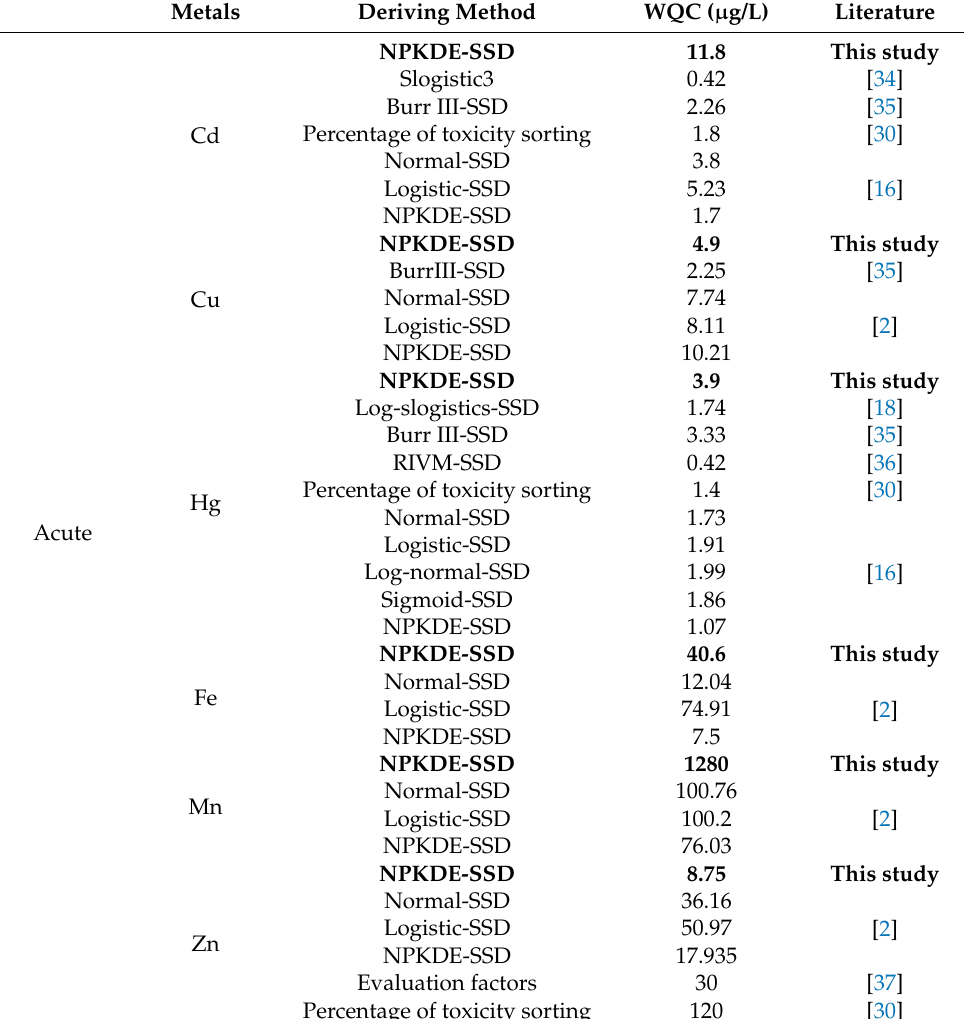
Table 2. Comparison of acute and chronic water quality criteria of transition metals of South Asia with values found in other